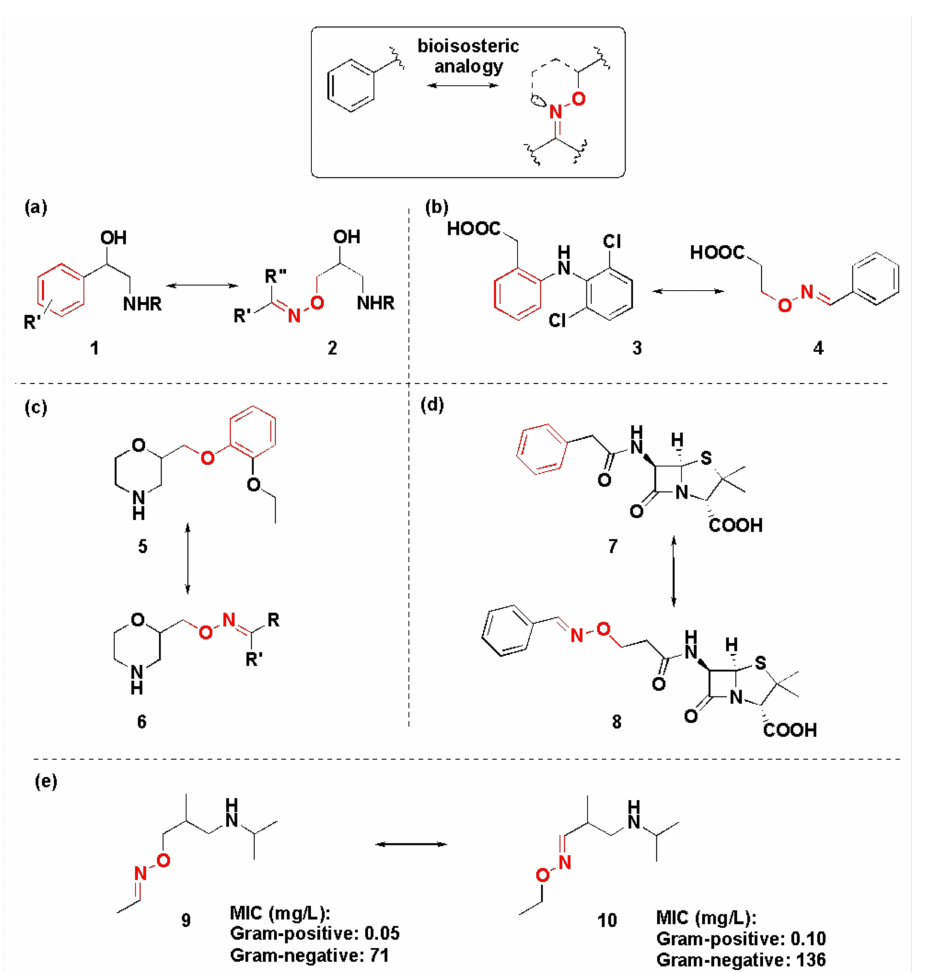
Figure 3. ( a – e ): Representative structures of MAOM moiety-modified bioisosteres of common bioactive compounds.